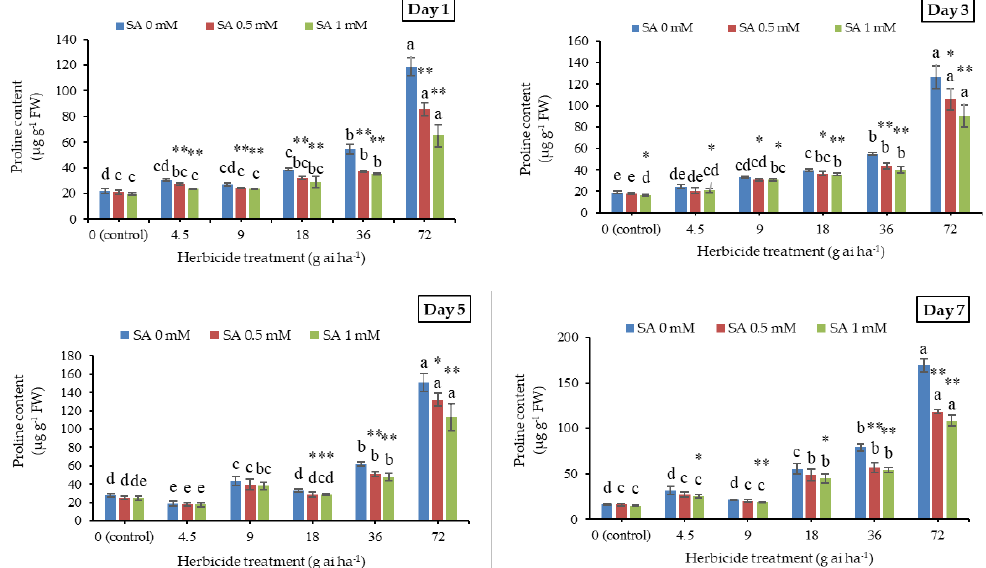
Figure 9. Changes in proline content in the leaf tissues of wheat at 1, 3, 5, and 7 days after herbicide application at different rates. The leaves were pre-treated with different concentration of salicylic acid (SA) 3 days prior to herbicide application. The bars represent the treatment mean ± SD ( n = 4), and the bars with different lower-case letters were significantly ( p ≤ 0.05) different , according to the Duncan ’ s test. Asterisks indicate significant difference between the herbicide only and herbicide with each concentration of SA, according to the Independent Samples t -test.